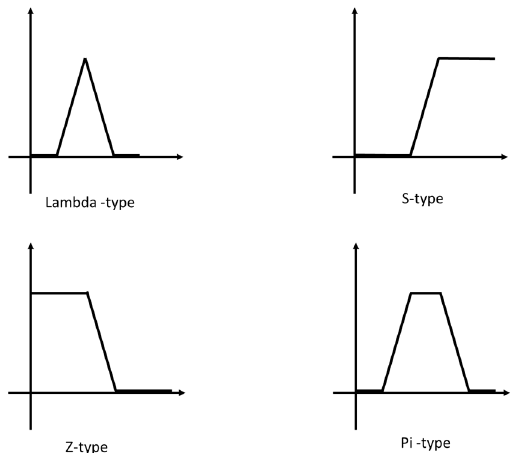
Figure 1. Standard membership functions.